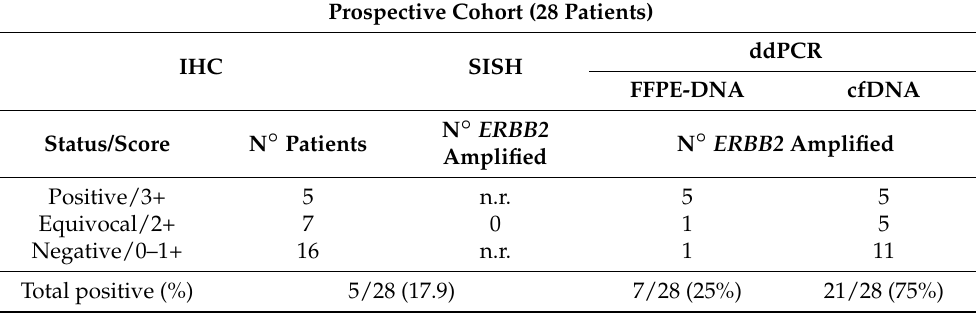
Table 4. HER2/ ERBB2 status in FFPE-DNA and cfDNA of prospective patients based on IHC/SISH and